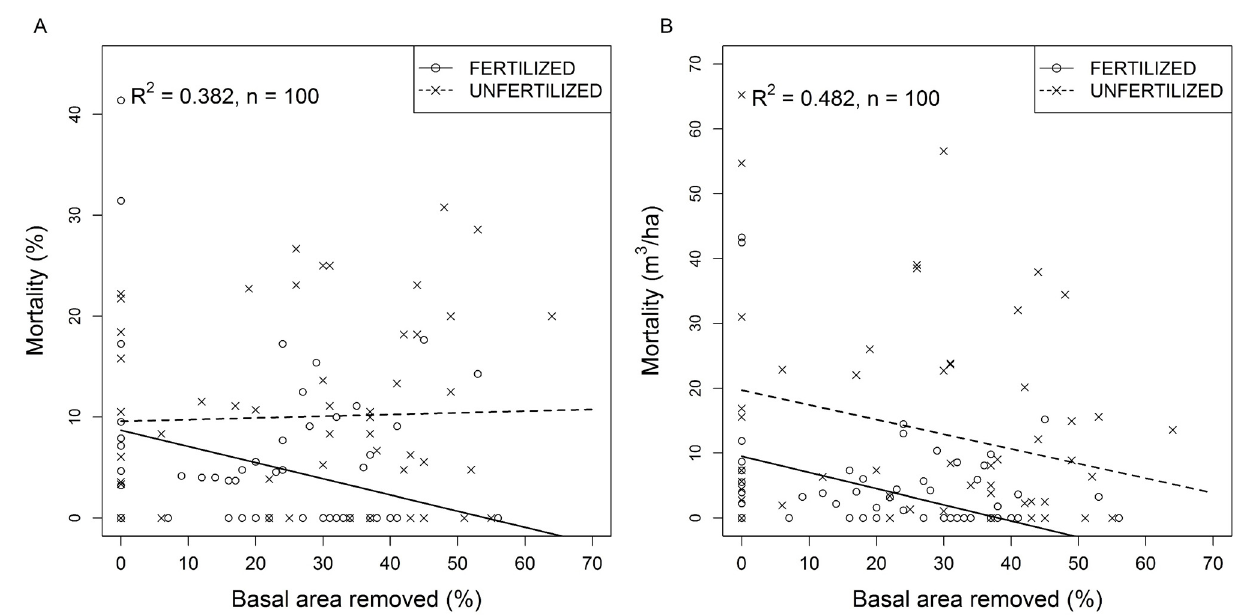
Figure 4. Jack pine stand response to commercial thinning and fertilization over periods of 5 to 14 years following thinning. Fertilization was conducted within sub-plots in each experimental unit 3 to 5 years after thinning. ( A ) Tree mortality (% of residual stems) as a function of basal area removed and fertilization over a period of 5 to 14 years after commercial thinning; ( B ) Volume lost to mortality as a function of basal area removed and fertilization over a period of 5 to 14 years after commercial